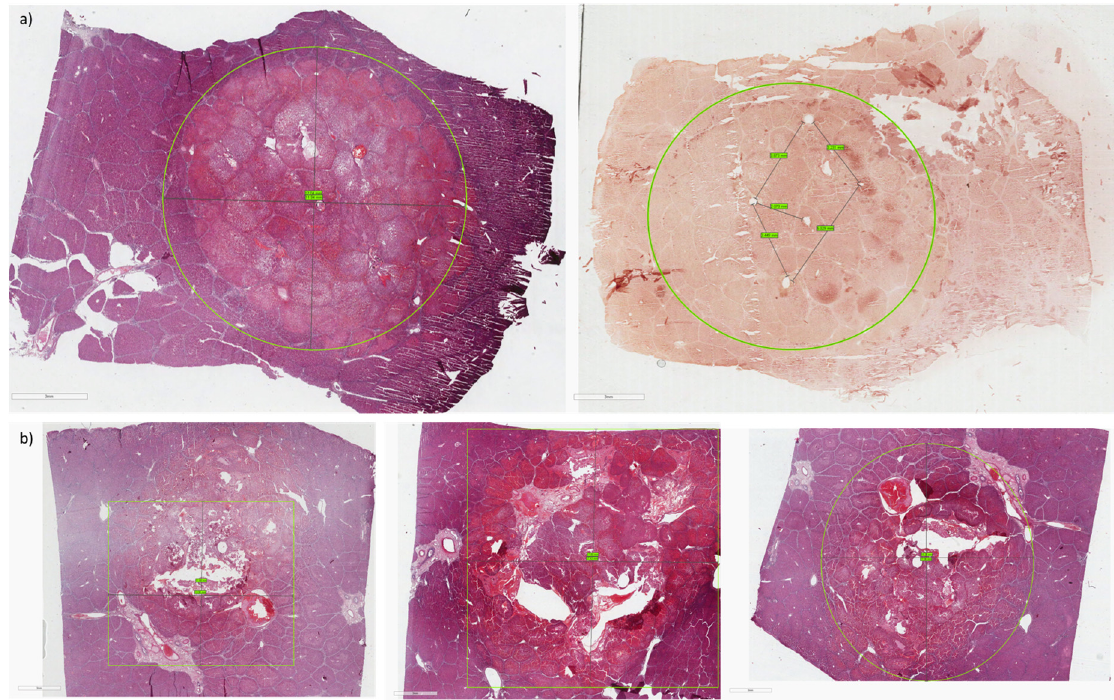
Figure 6. ( a ) Histological and immunohistochemical analysis on specimens treated with electrode with zero divergence; ( b ) Histological and immunohistochemical analysis on specimens treated with the 4-needle expandable electrode. In the circle or square it is possible to observe the size of the necrosis